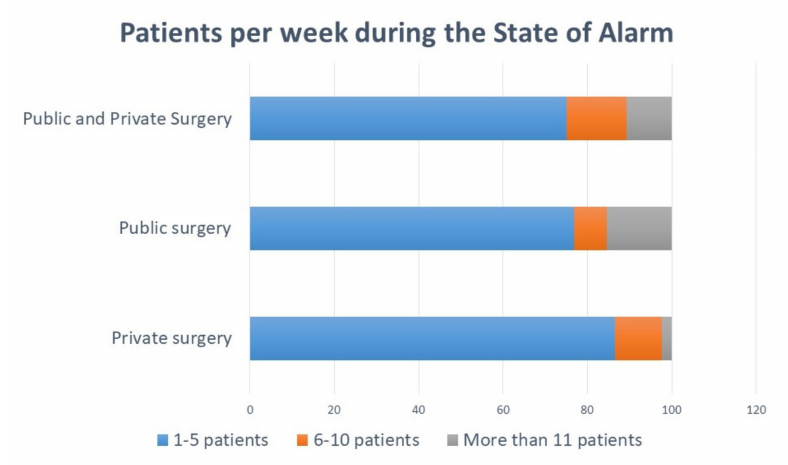
Figure 2. Patients per week during the State of Alarm in public and / or private